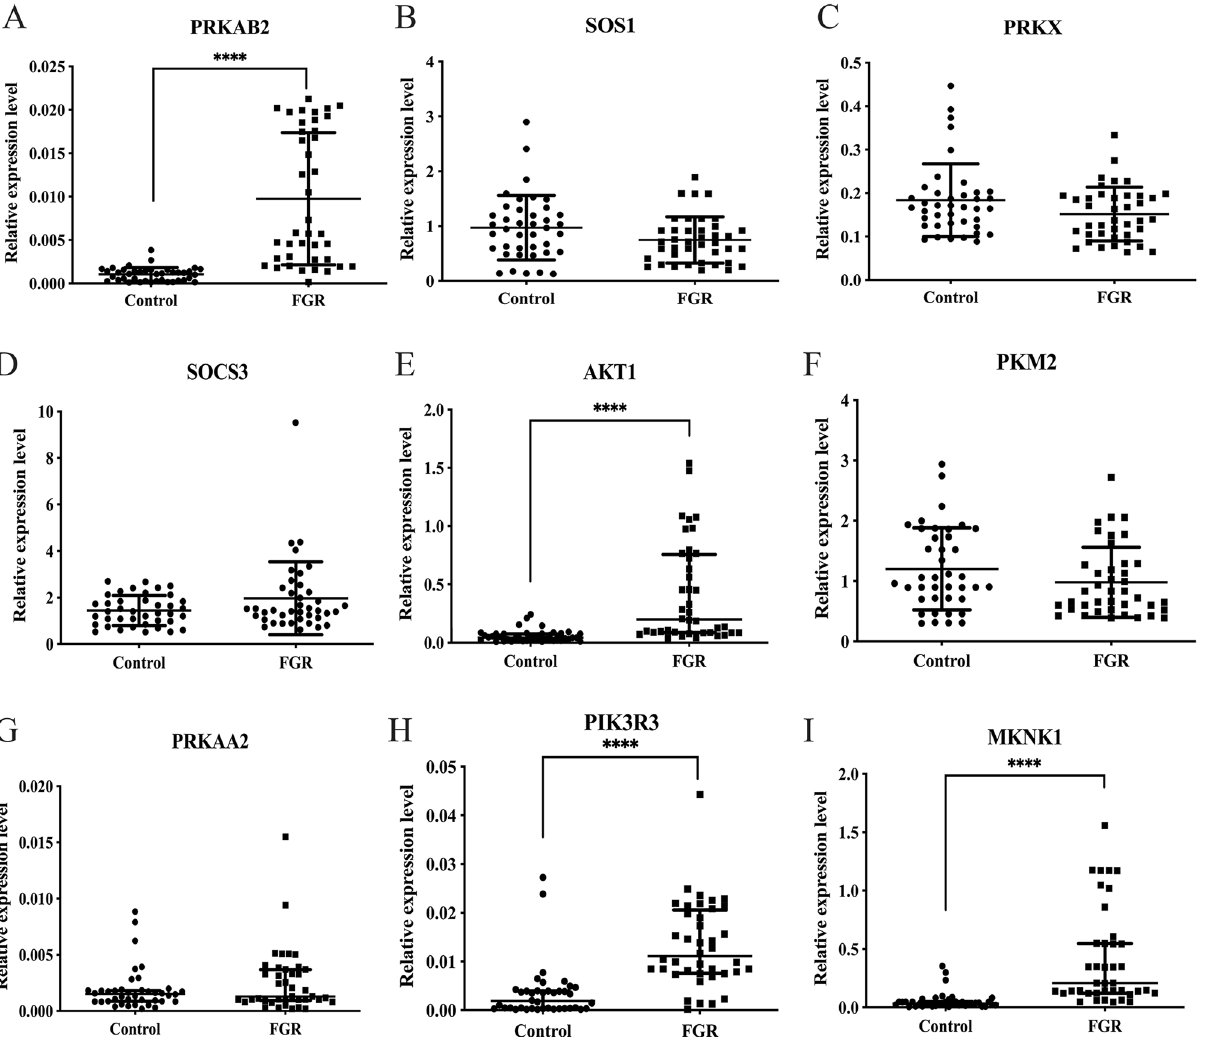
PRKAA2 ( G ) , PIK3R3 ( H ), and MKNK1 ( I ) in 40 FGR-affected placenta and 40 normal placenta. Data are given in Tukey Box plots showing median (−) value. Asterisks denote significant differences from controls (**** P <